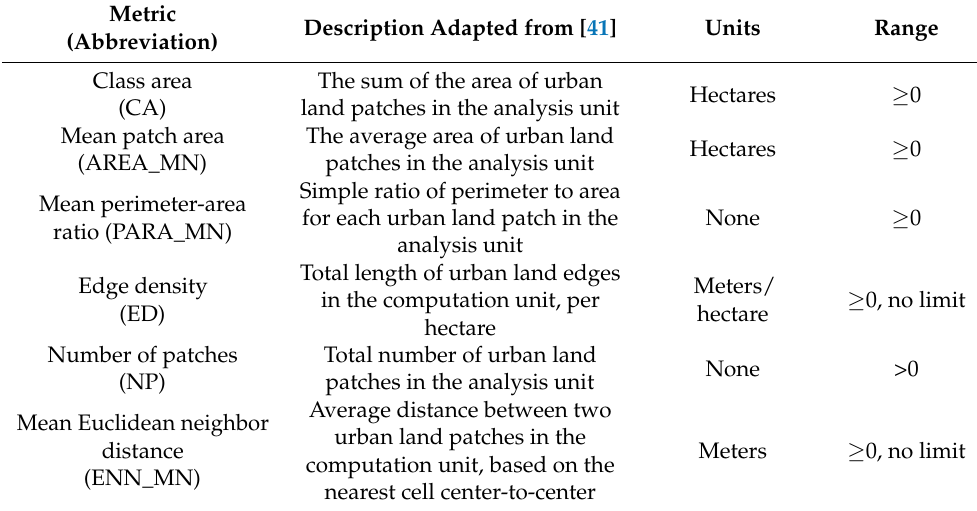
Table 2. Landscape metrics used in this study. Metric Description Adapted from [41] Units (Abbreviation)